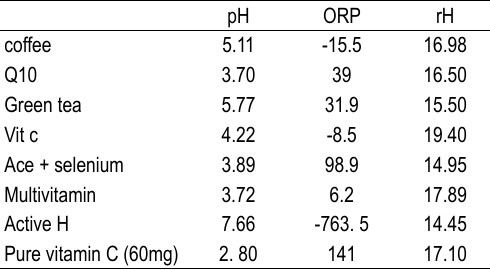
Table 1. determination of ph, rh, OrP of selected